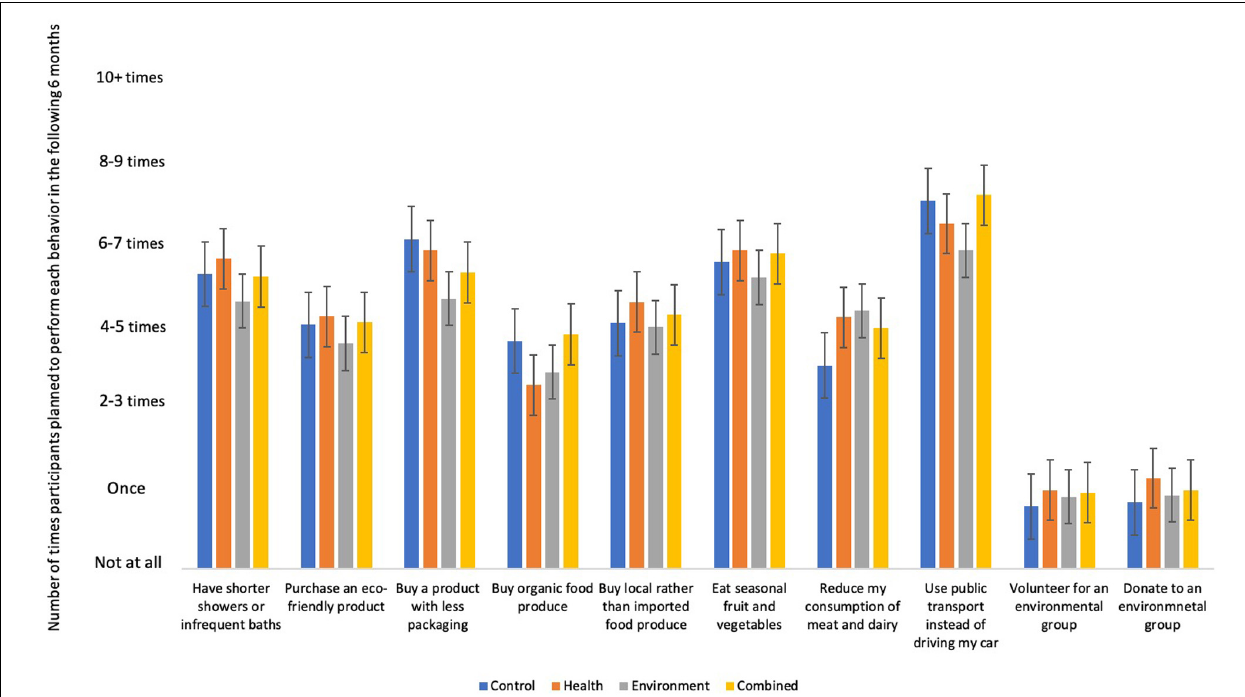
FIGURE 2 | Participants average willingness to perform pro-environmental behaviors at time 2.